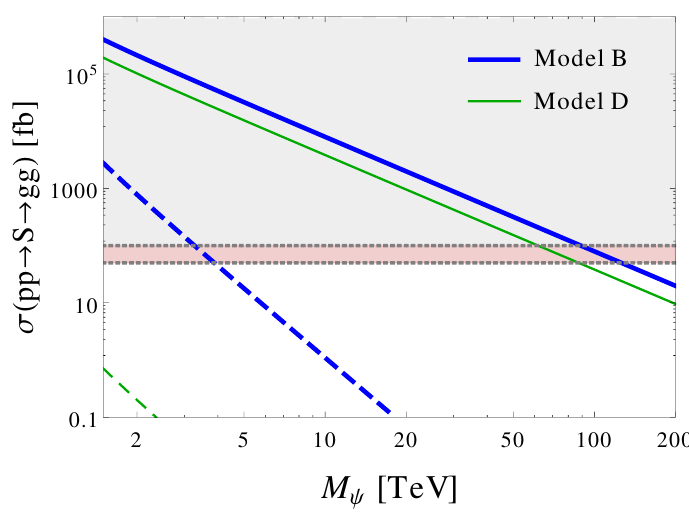
Figure 20 . Dijet cross section as a function of the BSM fermion mass M for benchmark B (thick blue curves), and benchmark D (thin green curves) for M S = 1 : 5 TeV. Solid curves correspond to the maximal interference between N F scalars, while dashed ones to no interference. The upper and lower horizontal dashed line denotes the ATLAS 95% C.L. limit [40] on the dijet cross section assuming 50% and 100% acceptance,